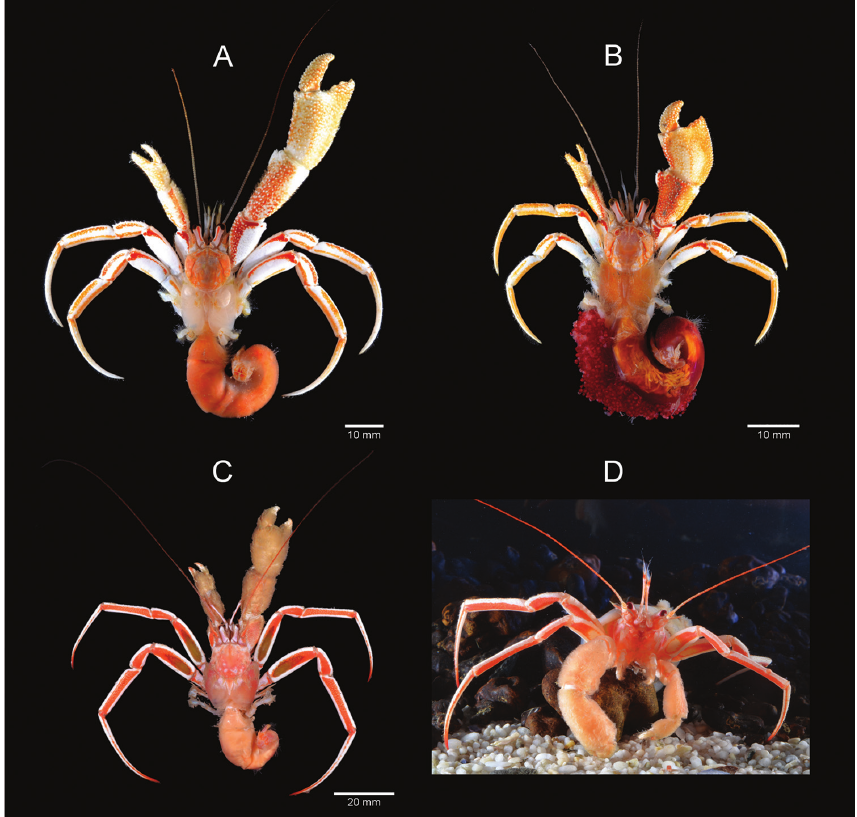
Figure 7. A, B Sympagurus dimorphus (Studer, 1883), South Coast C, D Parapagurus bouvieri Stebbing, 1910, West Coast ( C ), South Coast ( D ). A male 11.2 mm SCDSA 2016 (SAMC MB-A066492) B ovig. female 9.4 mm SCDSA 2016 (SAMC MB-A066491) C male 12.2 mm, WCDSS (SAMC MB-A066432) D male 10.6 mm, SCDSS2016 (SAMC MB-A066794), front view of live specimen in aquarium, using zoanthid ( Epizoanthus sp.) carcinoecia. chela mostly light amber with white spines or tubercles, and white patches medially; the carpus is orange dorsally, with white spines or tubercles; the merus is red dorsally, with bright white lateral and mesial faces. The colour pattern of left cheliped is similar to that of right cheliped. The ambulatory legs have dactyls mostly white except for a light orange proximally; the propodus and carpus are white except for two light orange stripes (one dorsolateral, and one ventrolateral) on the lateral face of both segments, and the mesial face of both segments are similar to the lateral face; the merus is bright white except for a dorsolateral red stripe broadening distally near the distal margin; the ischium is white with a dorsolateral light orange stripe. The pleon is orange or reddish. The uropods and telson are white with light orange. General distribution. Reported from the Southern hemisphere from 22°S to 57°S. Depth: 91–1995